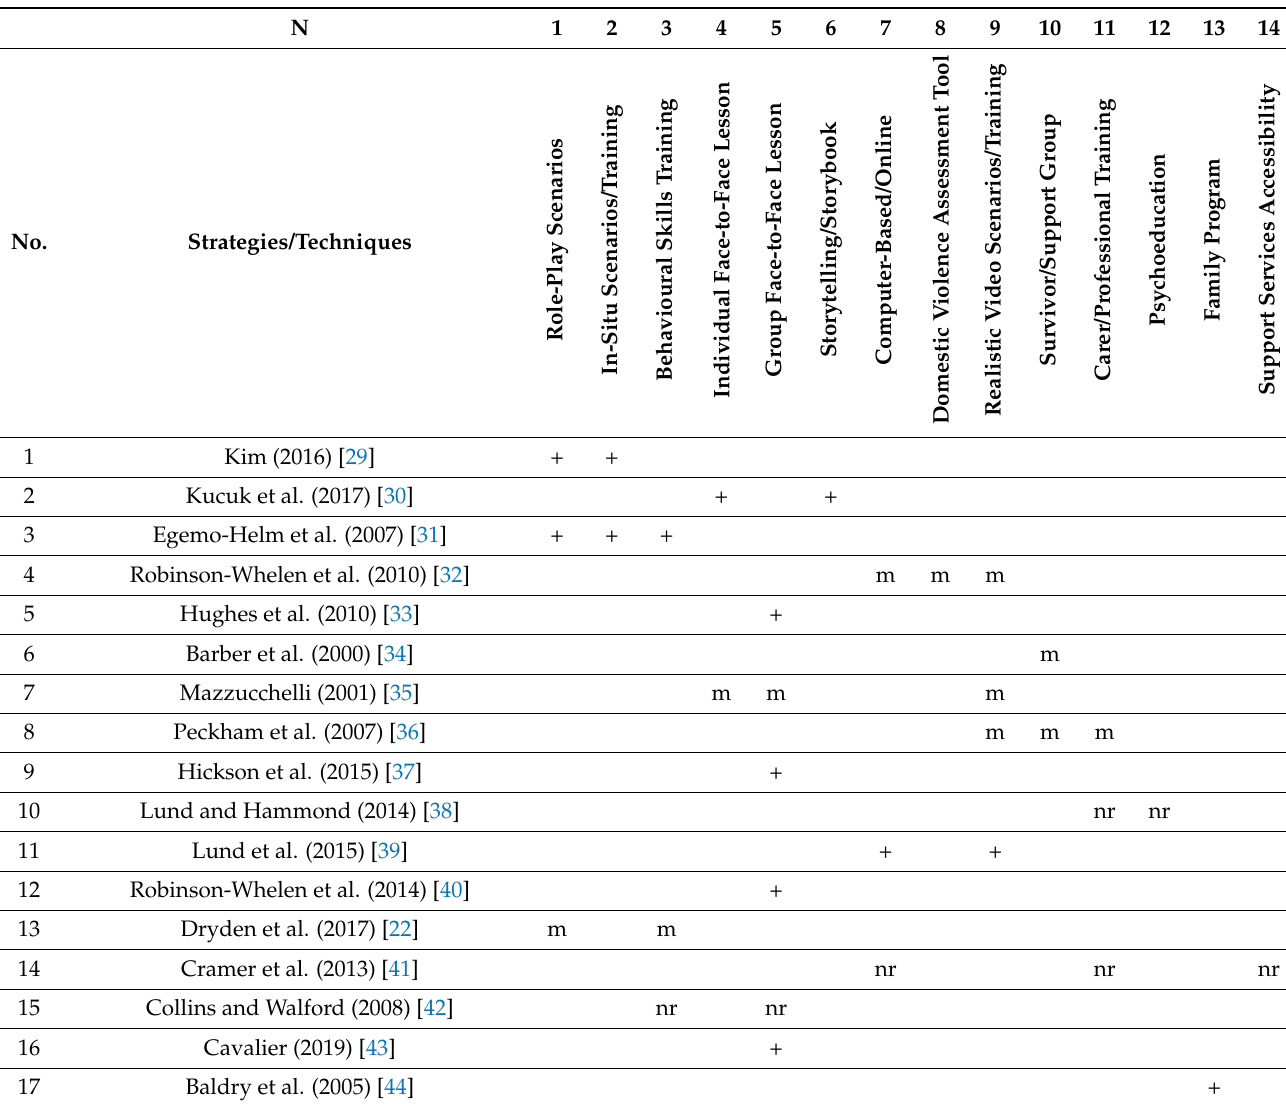
Table 4. Intervention strategies and